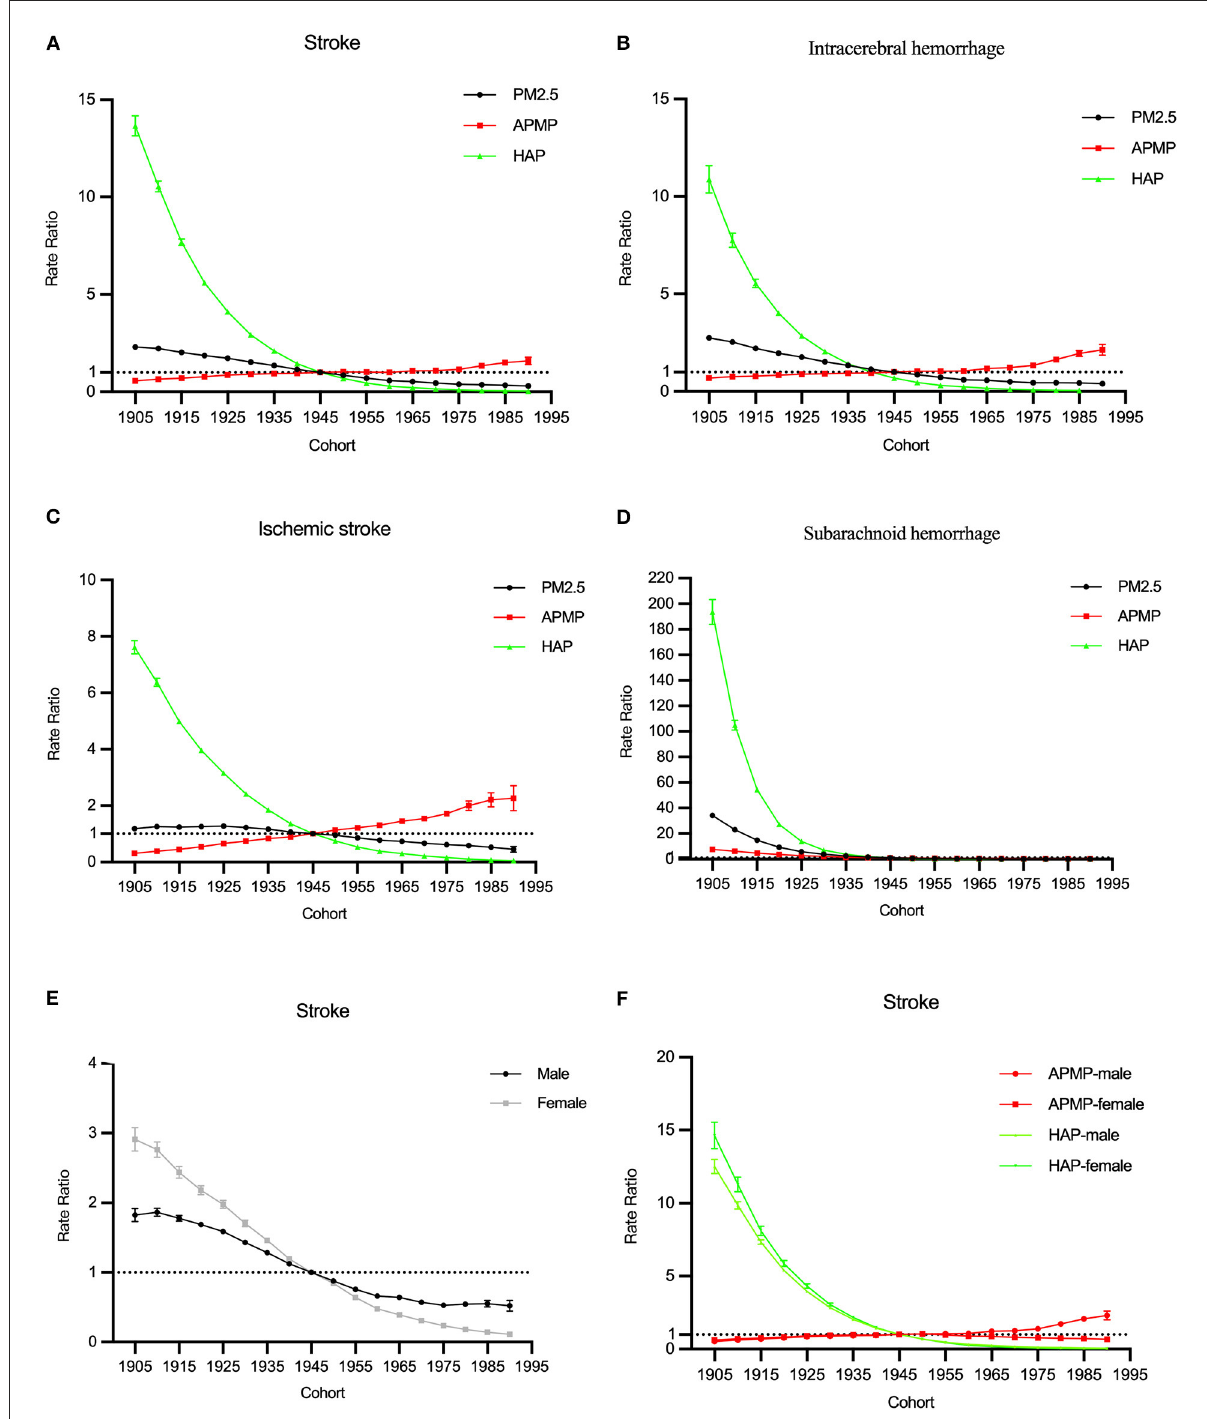
FIGURE4 The cohort RRs of the mortality rate of stroke attributable to PM2.5 exposure from 1990 to 2019. (A–D) The cohort RRs of stroke and subtypes for both sexes in PM2.5 exposure. (E) The cohort RRs of stroke by sex in PM2.5 exposure. (F) The cohort RRs of stroke by sex in ambient particulate matter pollution (APMP) and household air pollution